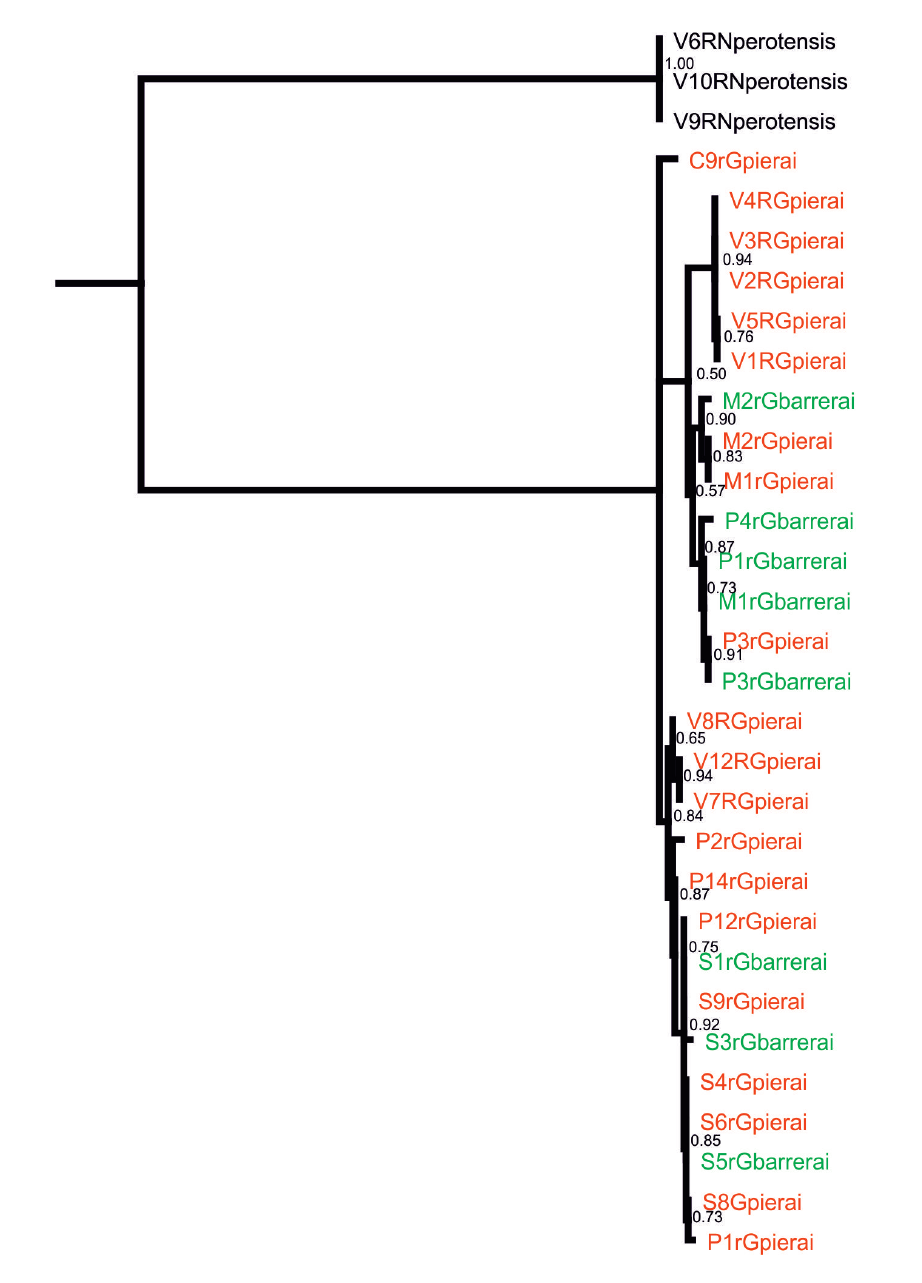
Figure 4. Label color indicates the morphological taxonomic assignation of each individual: red, G . pie- rai , green, G. barrerai , black, outgroup. Numbers at nodes are bootstrap values (500 rep.; only values ≥0.5 are